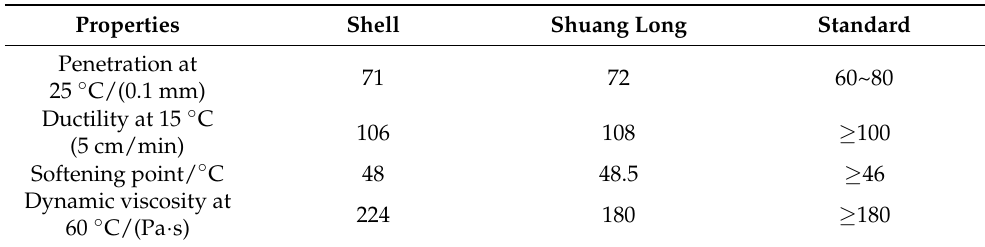
Table 1. Properties of base asphalt binders.